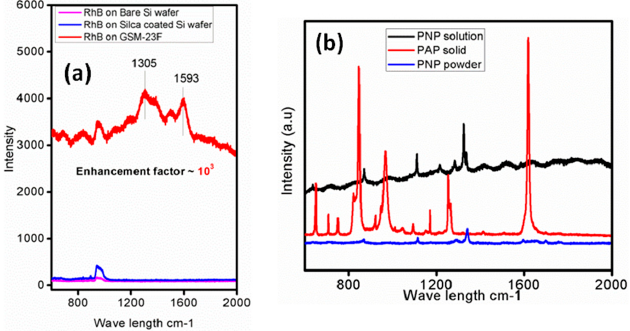
Figure 5 . SERS spectra of rhodamine B on GSM-23F thin film and the bare silicon substrate ( a ) and the Raman spectra of the 4-nitrophenol (PNP), 4-aminophenol (PAP) ( b ) under 633 nm laser excitation source.